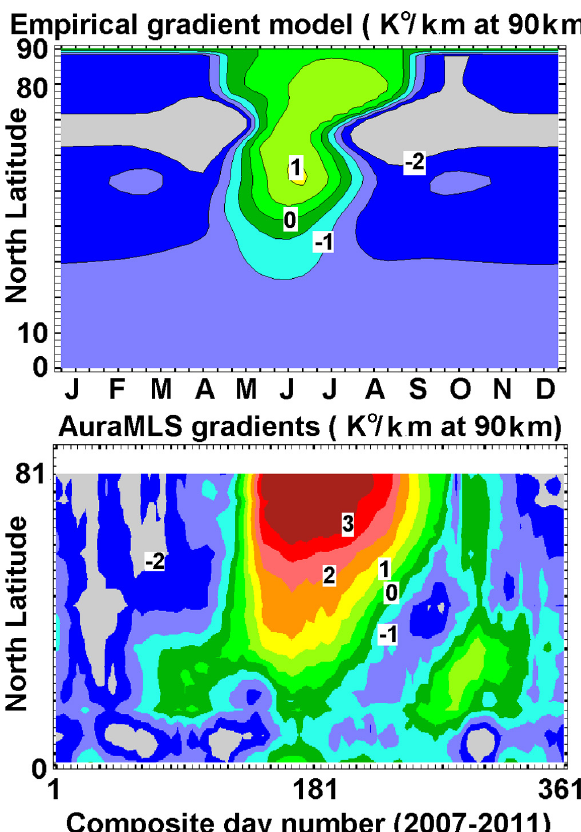
Fig. 3. Comparison between the SKiYMET empirical gradient model and the 9 pt. fit MLS